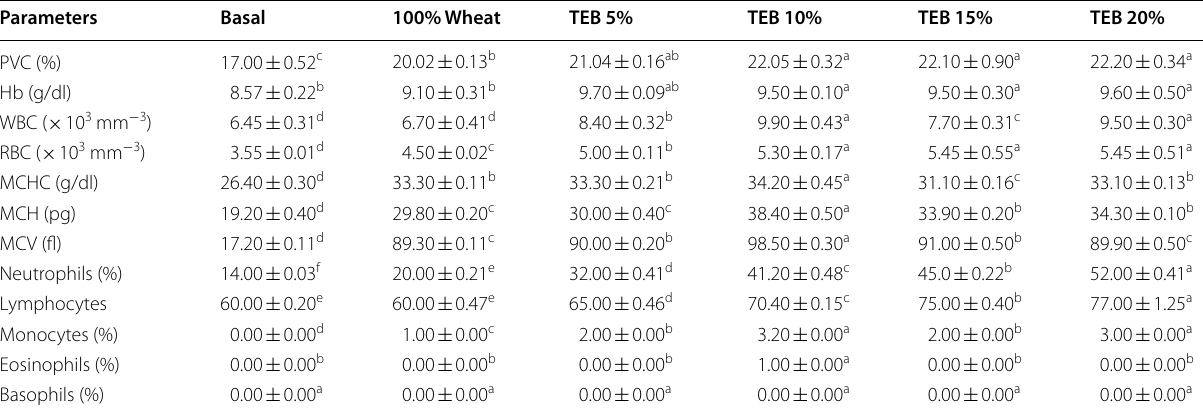
Means ( SEM) with different alphabetical superscripts in the same row are significantly different at P < 0.05 ± 100% Wheat: Rats fed with 100% wheat flour